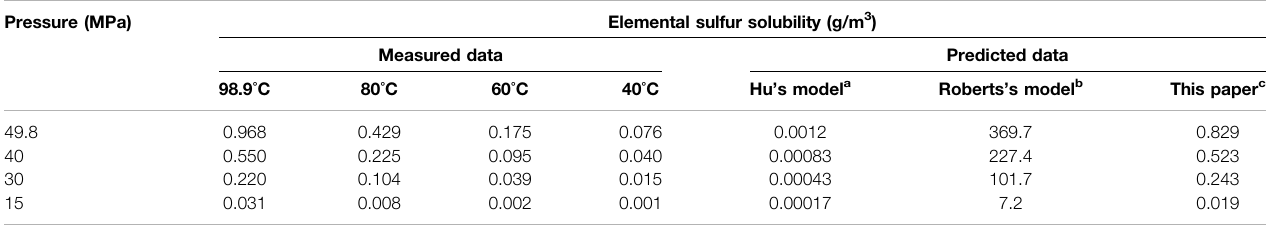
TABLE 1 | Solubility of elemental sulfur in well M1 by experiments and predictions. Pressure